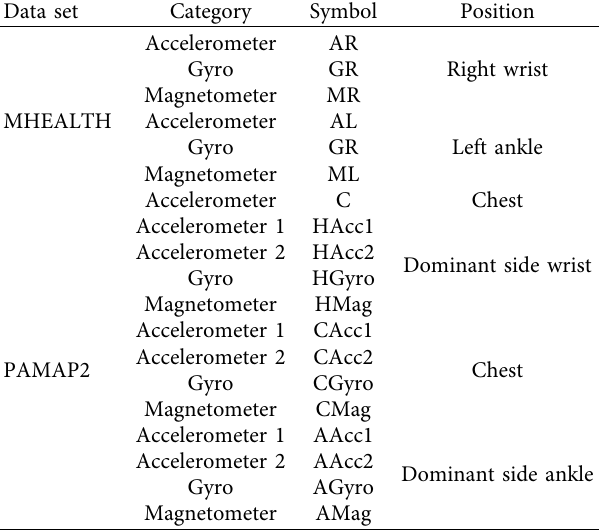
Table 2: Classifier